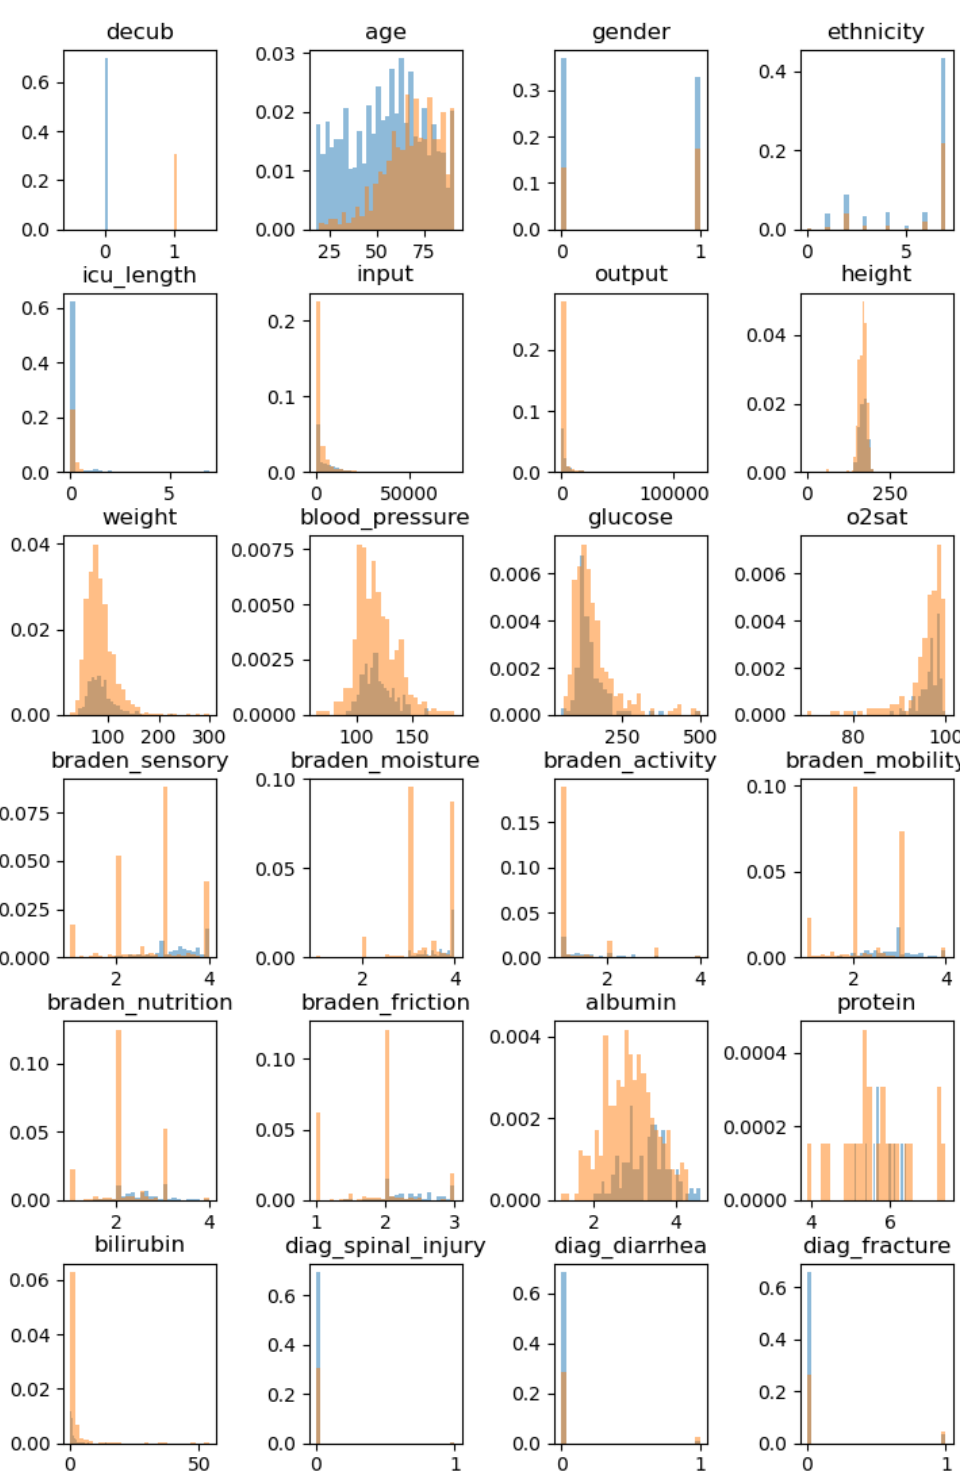
Figure 1. Histograms of non-debiased input parameters before normalization. The PU group is represented by blue color, while the orange color represents non-PU group.